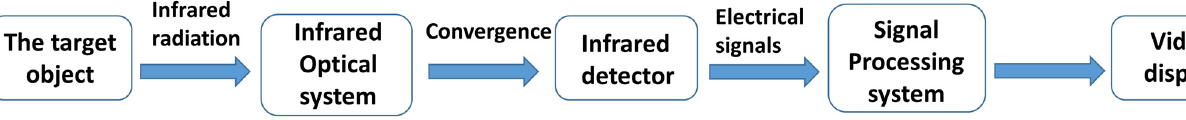
Figure 1. The working principle of the IRT imaging camera.